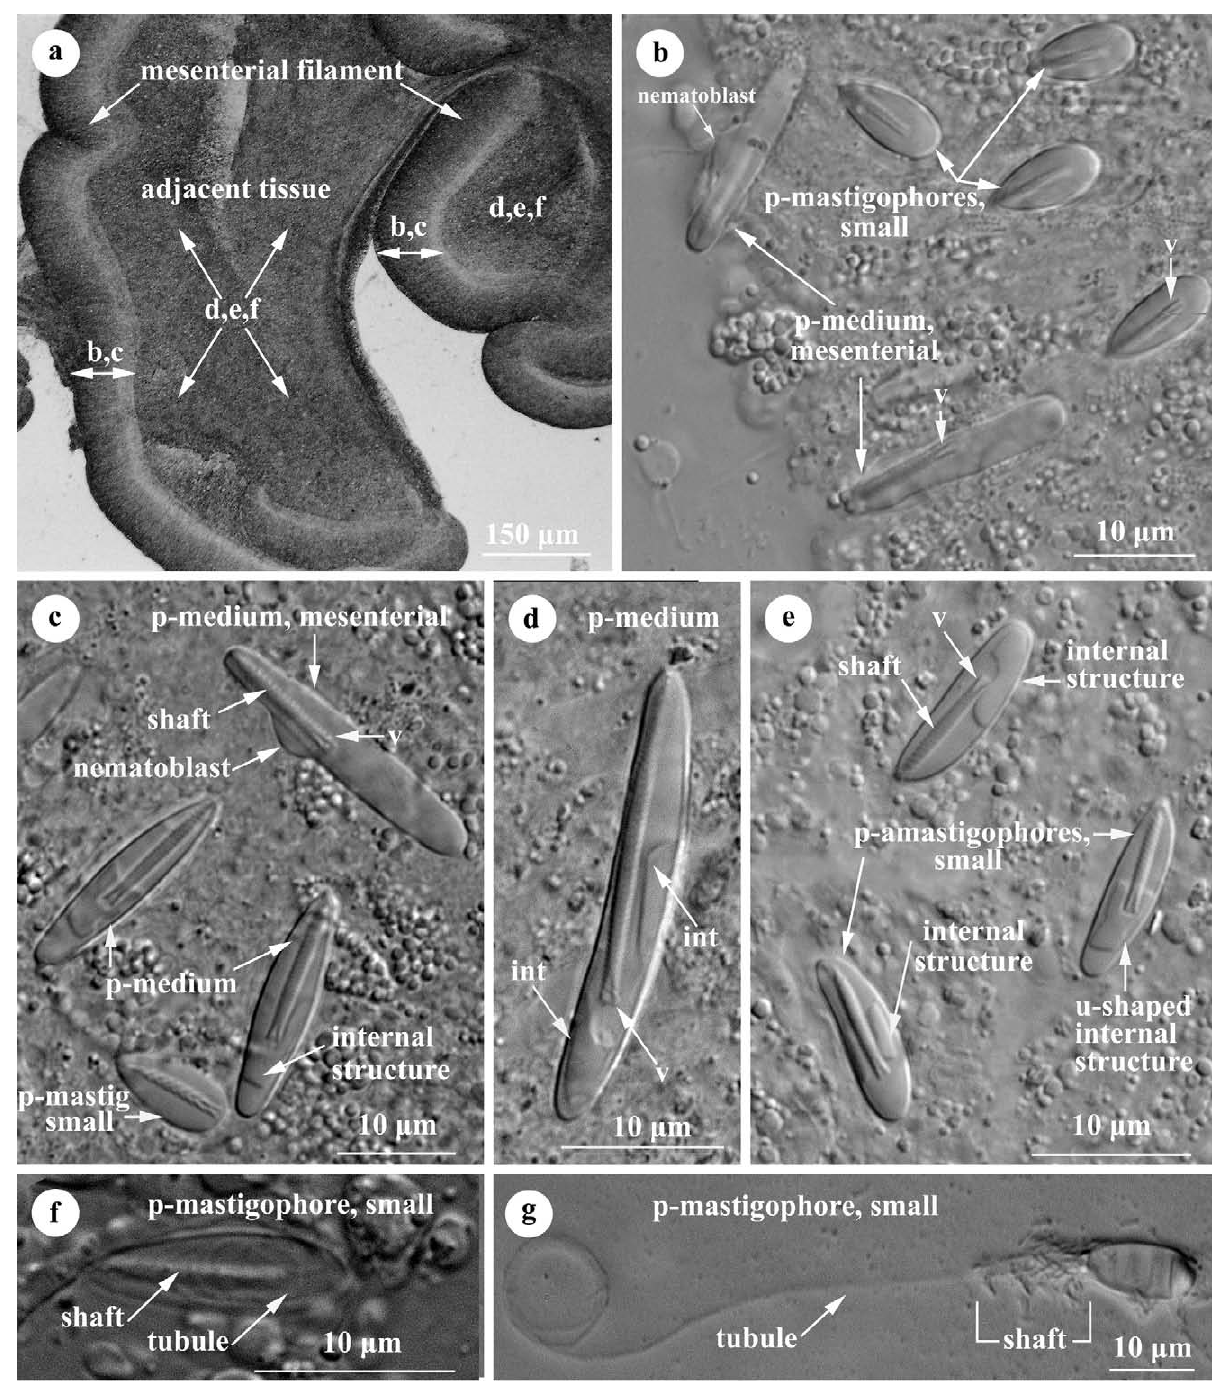
Fig . 3. – Mesentery p-mastigophores and p-amastigophores. a) Edge of mesentery showing filament and adjacent tissue. Arrows indicate zones of tissue for figures b,c (filament) and d,e,f (adjacent tissue). b) 4 p-mastigophores, drop-shaped, 2 p-amastigophores, medium, me- senterial. c) One p-mastigophore, drop-shaped (immature), 3 p-amastigophores, medium, one of mesenterial type; note its short shaft. d) A p-amastigophore, medium, with long shaft and conspicuous internal capsular matrix. e) 3 p-amastigophores, small, with irregular internal structure. f,g) p-mastigophores, drop-shaped. f) Tubule coiled within capsule. g) Discharged shaft and detached spines. int , internal structure; p-mastig, p-mastigophore; p-medium , p-amastigophore, medium; v, V-shaped notch at shaft b-mastigophores. Swollen mesobasic p-amastigo- in spaced right-handed spine-rows (Fig. 2c,e). On the phore shaft were more conspicuous than flattened main shaft spines were dense in dense spine-rows short shafts. Spines on the proximal shaft were sparse (Fig. 2c,d).